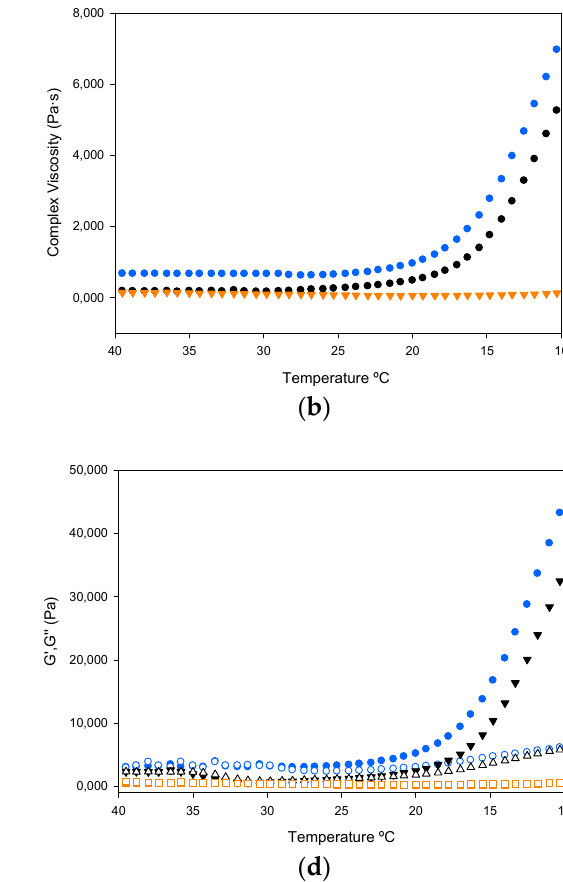
Figure 5. Variation of complex viscosity ( a , b ); and storage modulus (G ′ , filled symbols) and loss modulus (G ″ , empty symbols) ( c , d ); gelatin hydrogels (30% wt in water) with temperature. Heating ramp (left column) from 10 to 40 °C, cooling ramp (right column) from 40 to 10 °C. (blue circle) seabass, (ochre square) trout and (black triangle) seabream gelatins.